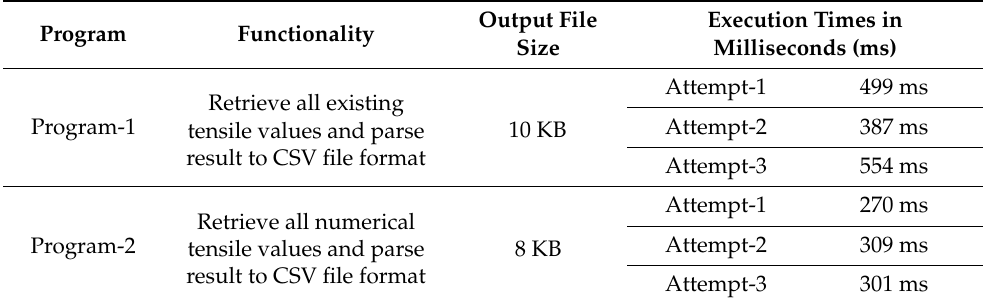
Table 2. Execution times for data retrieval from database and parsing the resultant JSON file to CSV file